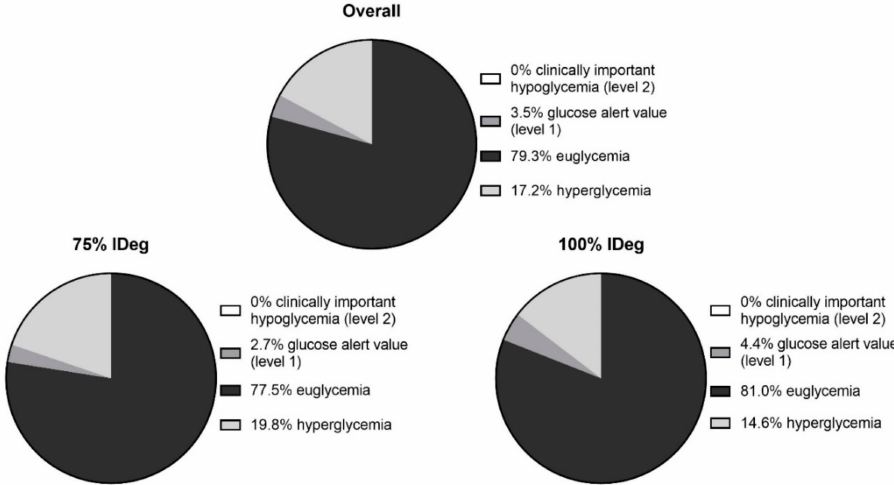
Figure2. Timespentinglycemicrangesassessedviacapillarybloodglucoseconcentration(BiosenS-line, EKF Diagnostics, Barleben, GER) during the continuous exercise sessions for all participants.